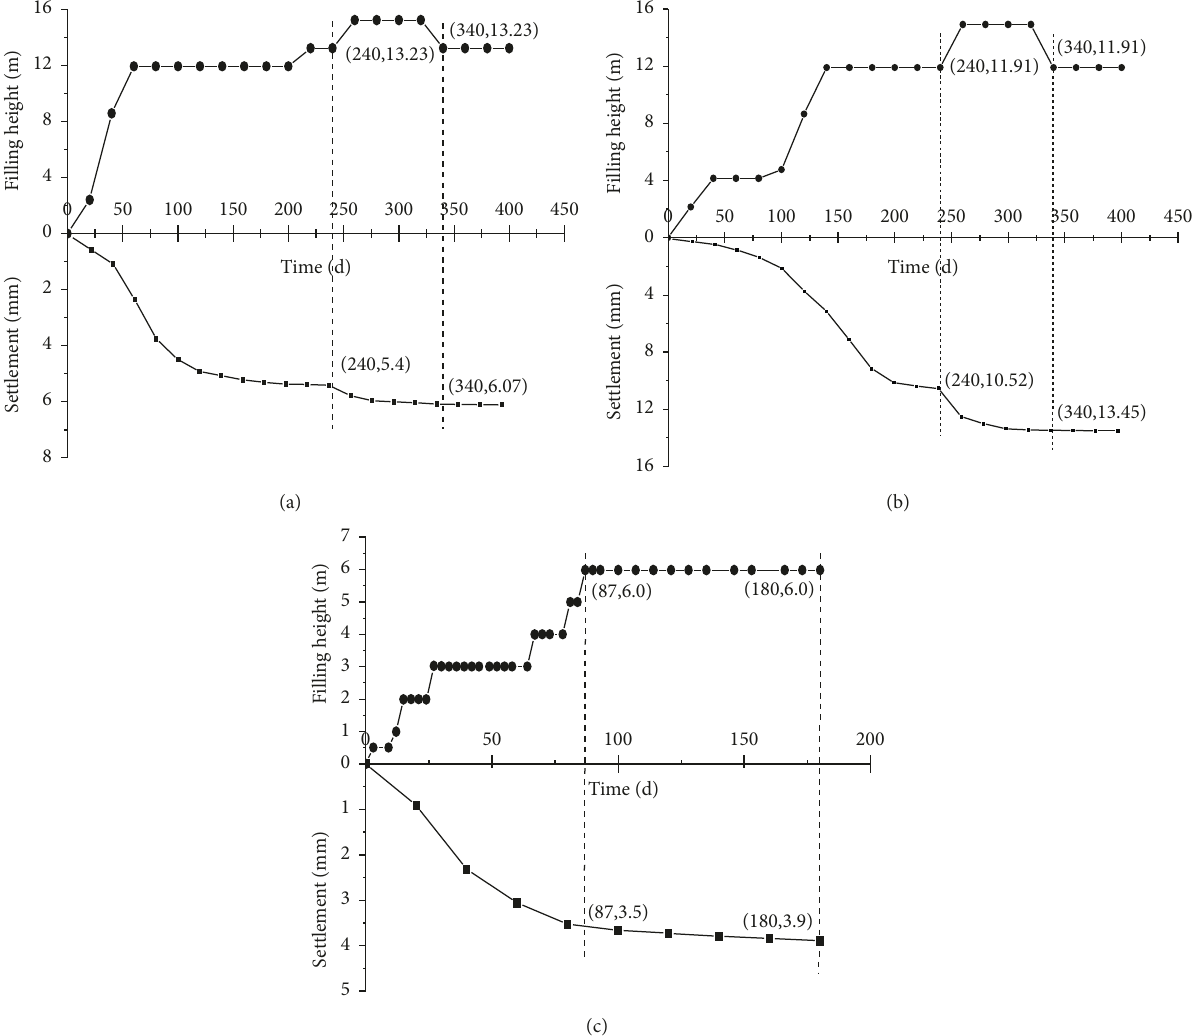
Figure 1: Subgrade filling height-settlement-time curve. (a) DK84 +771. (b) DK84 +821. (c) DK123